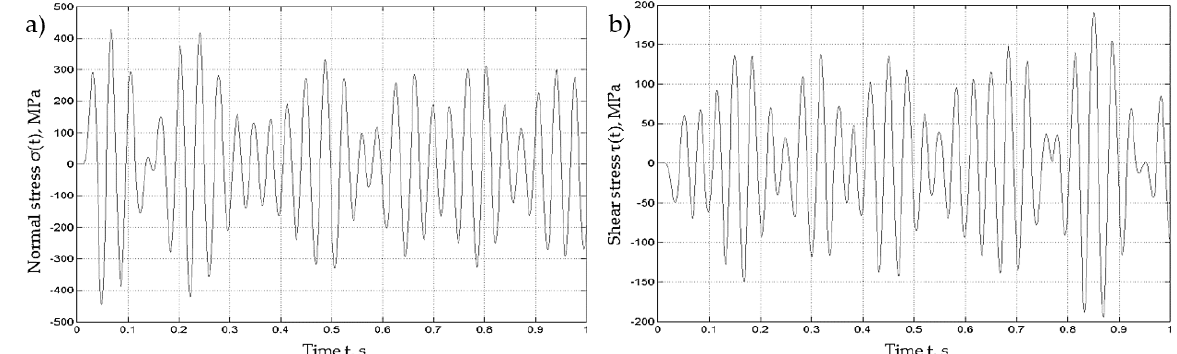
Figure 2. Pseudorandom stress histories in time: ( a ) normal stress σ ( t ); and ( b ) shear stress τ ( t ). Adopted from [33].